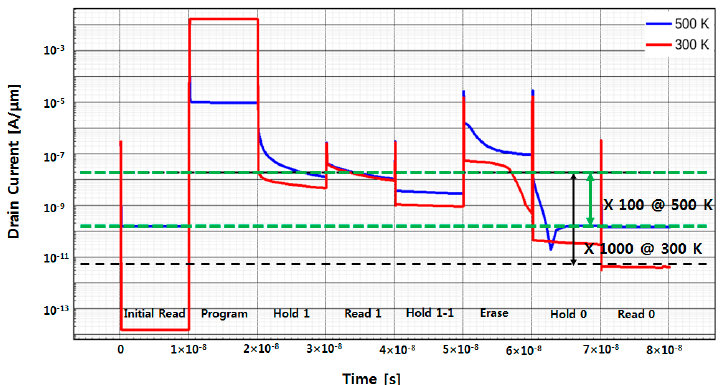
Figure 6. Transient simulation results for memory operations of the proposed 1T DRAM at 300 K and 500 K.